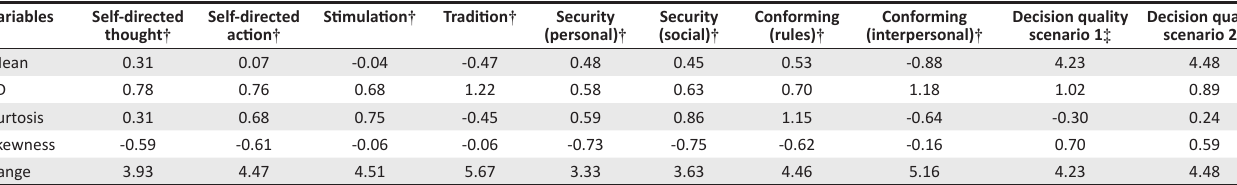
TABLE 1: Descriptive statistics.